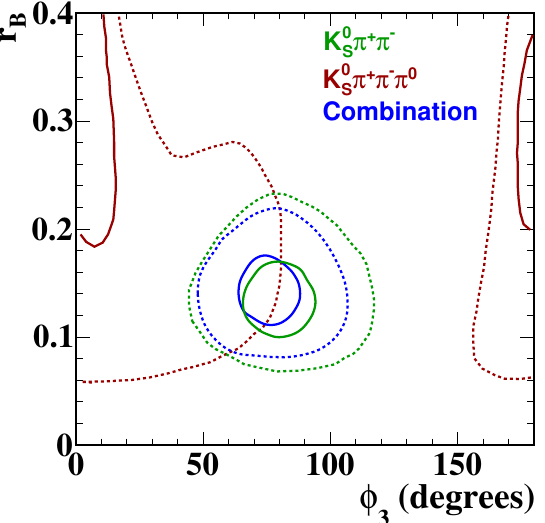
Figure 11 . Projections of the con(cid:12)dence contours in the (cid:30) 3 (cid:0) r B plane from multibody D (cid:12)nal states at Belle, which is shown by the blue contours. The results from B ! DK ( (cid:3) ) decays with D ! K 0 (cid:25) + (cid:25) (cid:0) are shown by the green contours and the D ! K 0 S the brown contours. The solid and dashed curves correspond to one and two standard deviation contours, respectively [11,